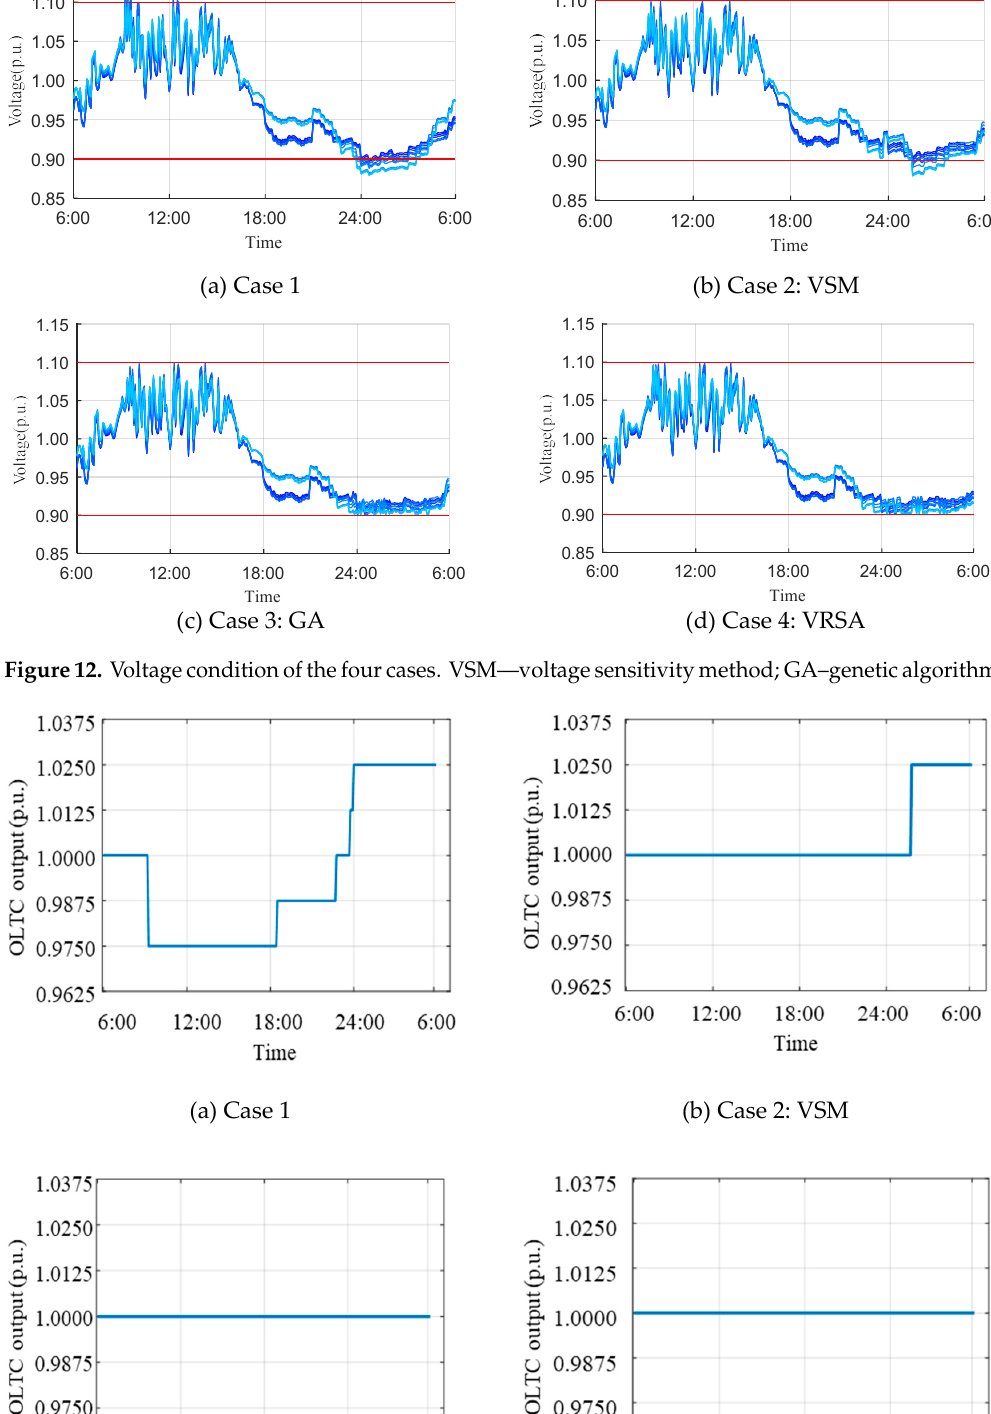
Figure 11. The total changed CL schedule.